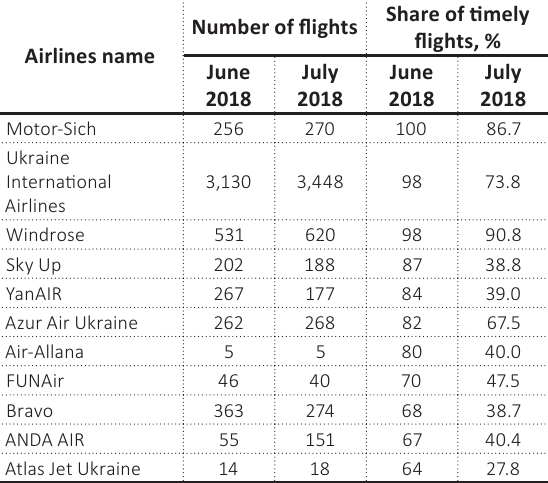
Table 3. Indicators of the punctuality of flights by Ukrainian airlines in June-July